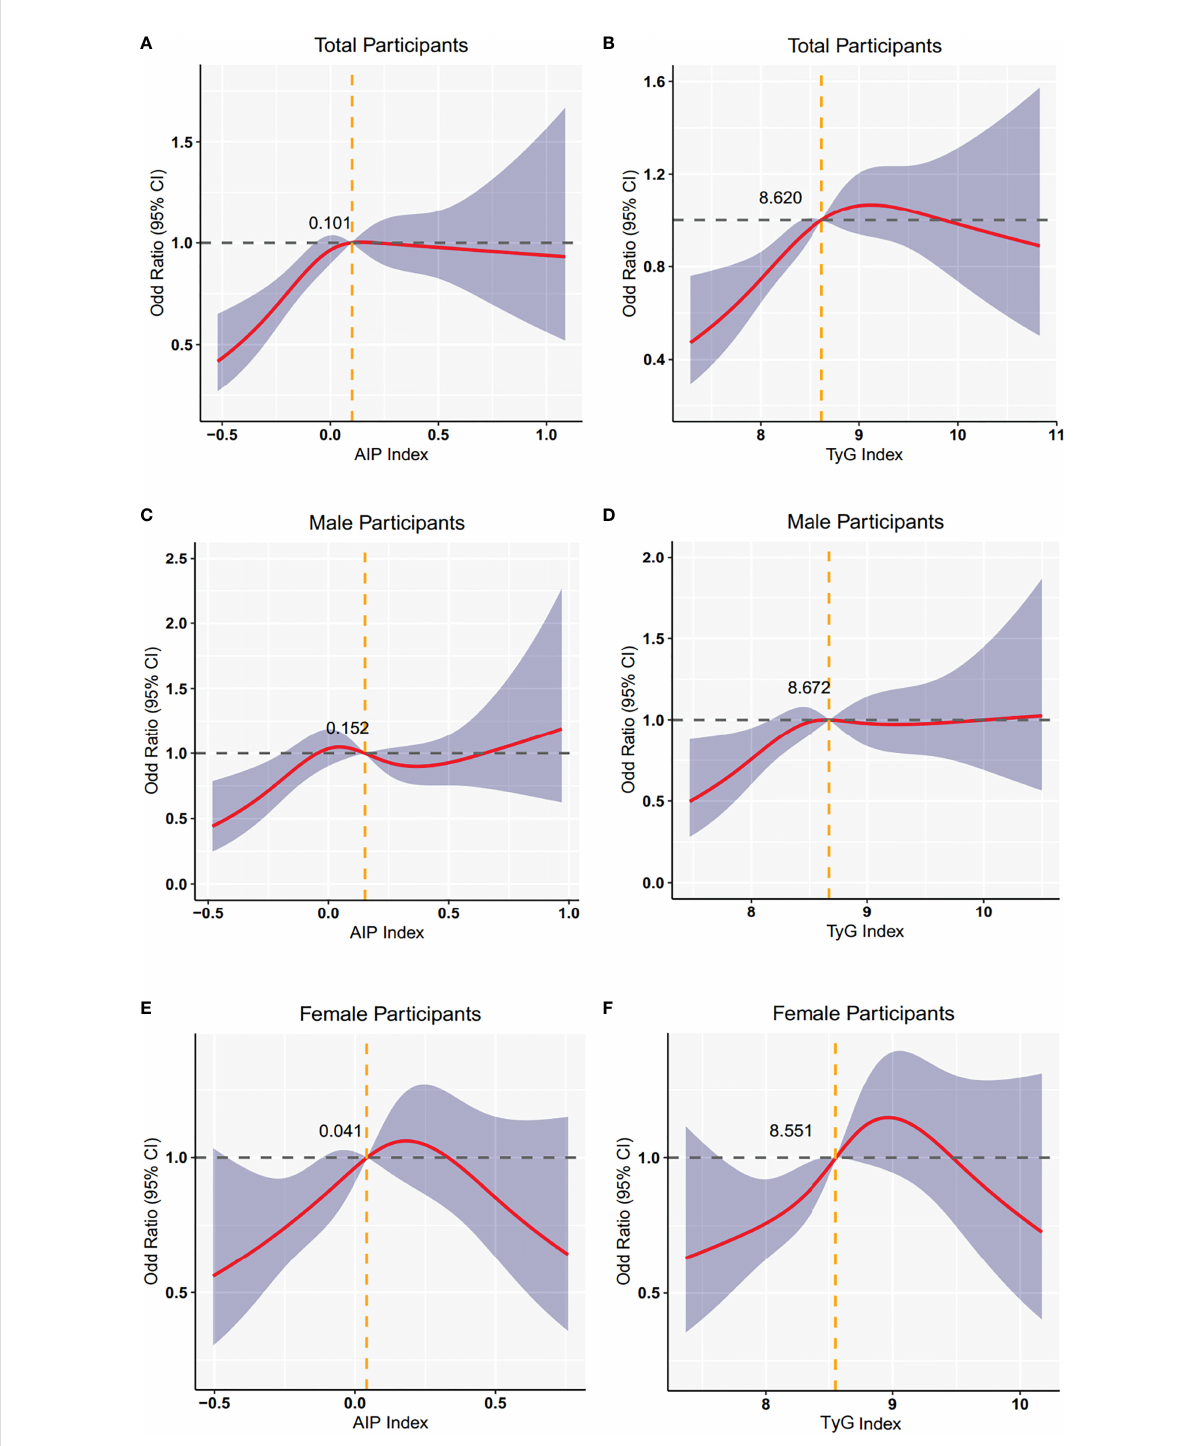
FIGURE 2 Restricted cubic spline plot of the association between TyG, AIP index and neoplasm in non-CVD participants. (A) the association between AIP and neoplasm in total participants. (B) the association between TyG index and neoplasm in total participants. (C) the association between AIP and neoplasm in male participants. (D) the association between TyG index and neoplasm in male participants. (E) the association between AIP and neoplasm in female participants. (F) the association between TyG index and neoplasm in female